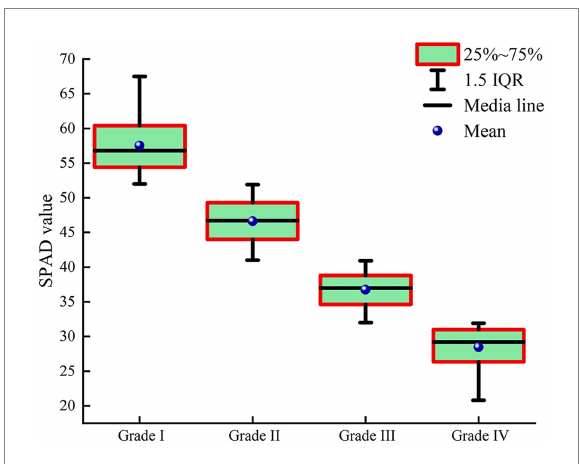
FIGURE 3 Variations in SPAD values of jujube leaves for different leaf mite infestation levels.